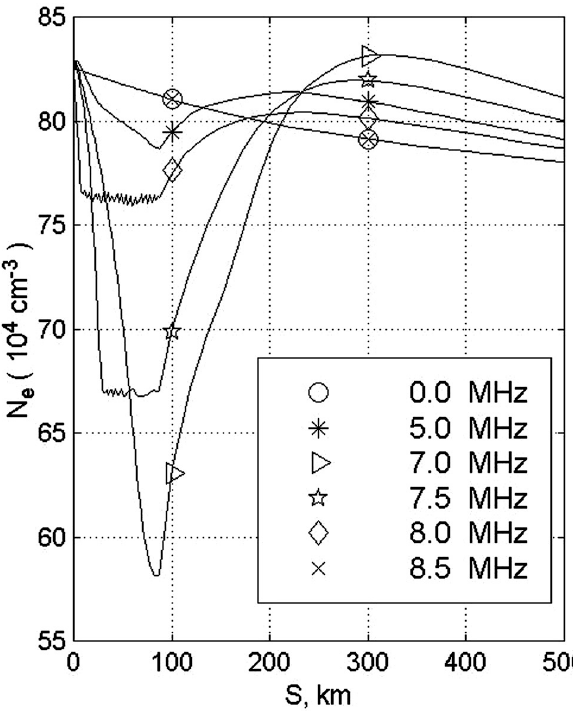
Fig. 13. The variations of the electron concentration (in units of 10 4 cm − 3 ) along the considered part of the convection trajectory at the level of 260km. The captions are the same as in Fig. 12.